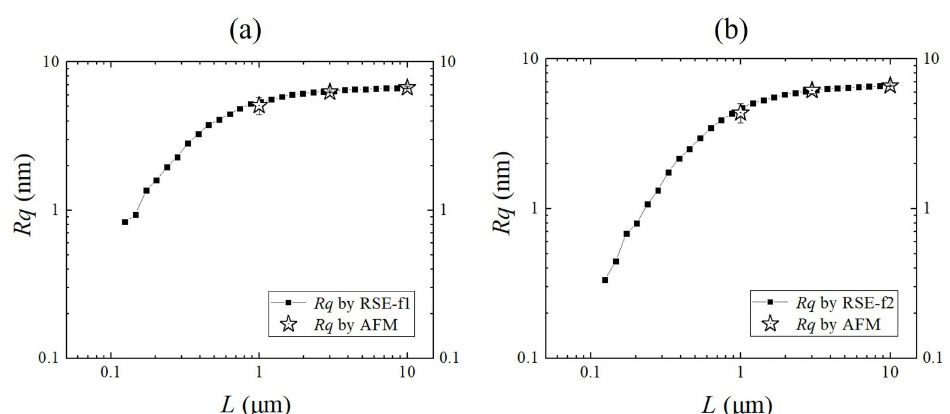
Figure 13. Rq values obtained by actual AFM measurements at L of 1, 3 and 10 µ m (denoted with star symbols) and Rq - L curves obtained with ( a ) RSE-f1 and ( b ) RSE-f2 methods (denoted with squared